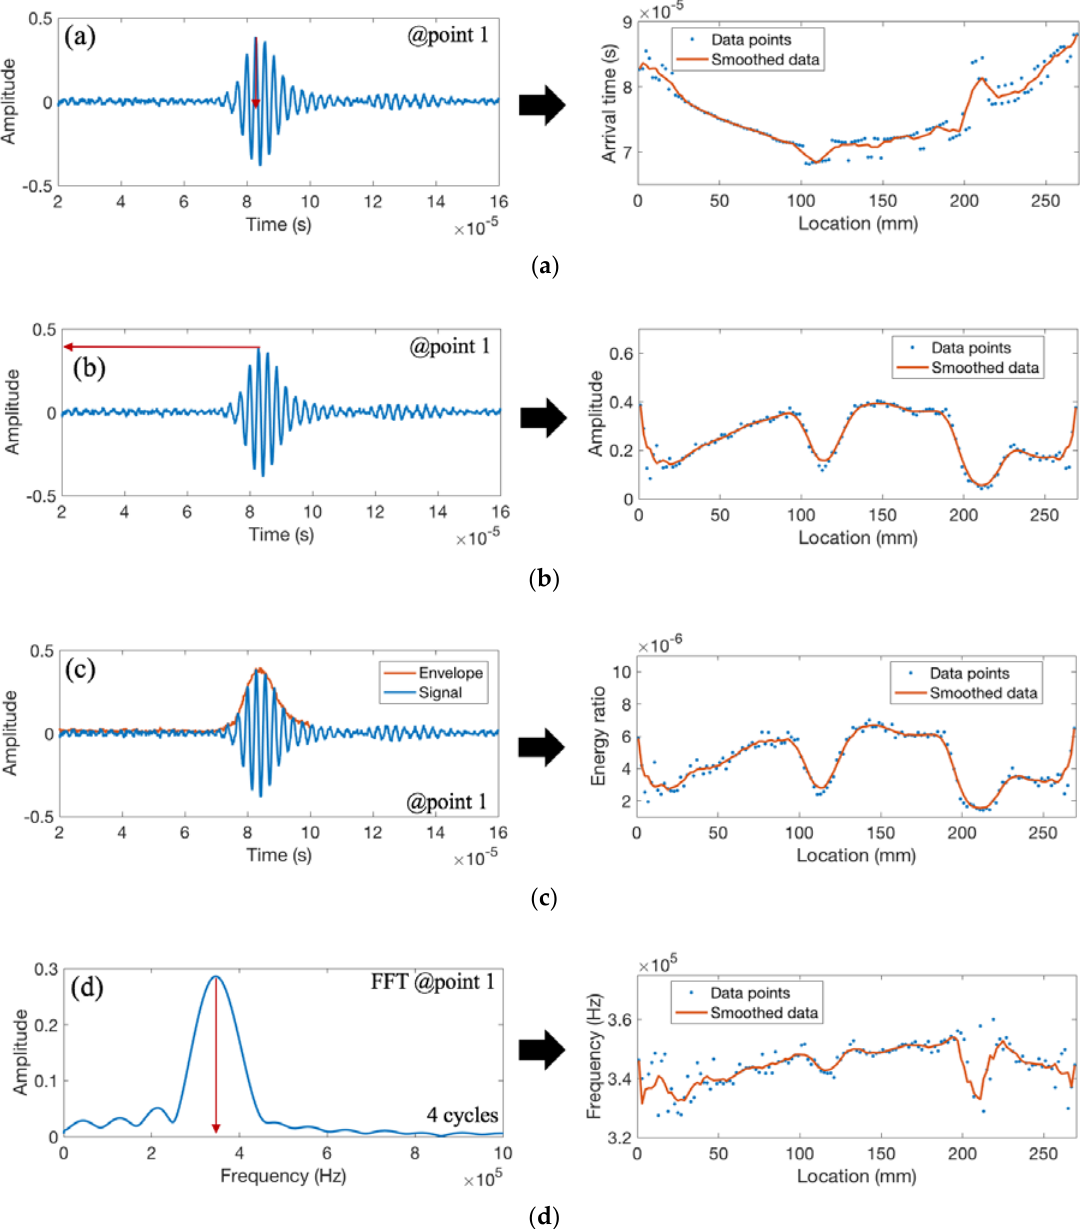
Figure 12. The recorded waveform and features extracted from weld coupon No. 3 corresponding to ( a ) the arrival time of the peak amplitude; ( b ) the peak amplitude; ( c ) the area under the envelope of the first arrived waveform; and ( d ) the peak frequency.